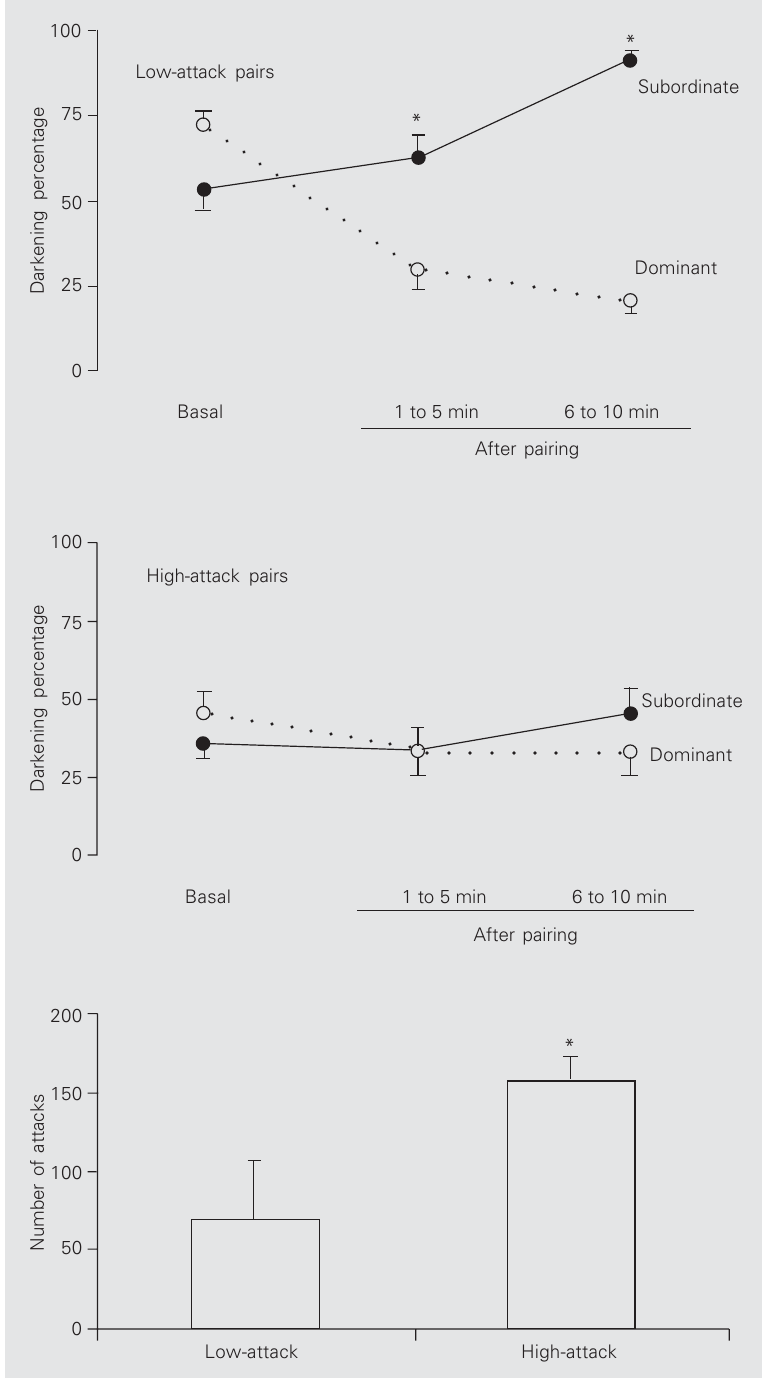
Figure 1. Effect of hierarchical rank on eye-darkening pattern in the high-attack and low- attack group of Nile tilapia. Data are reported as mean percent darkness ± SD, which indicates the black area (%) of sclera and iris region. Low-attack group, N = 4, and high- attack group, N = 3. *Difference over time (P = 0.0001, Friedman test) and between ranks after pairing (P < 0.05, Mann-Whitney